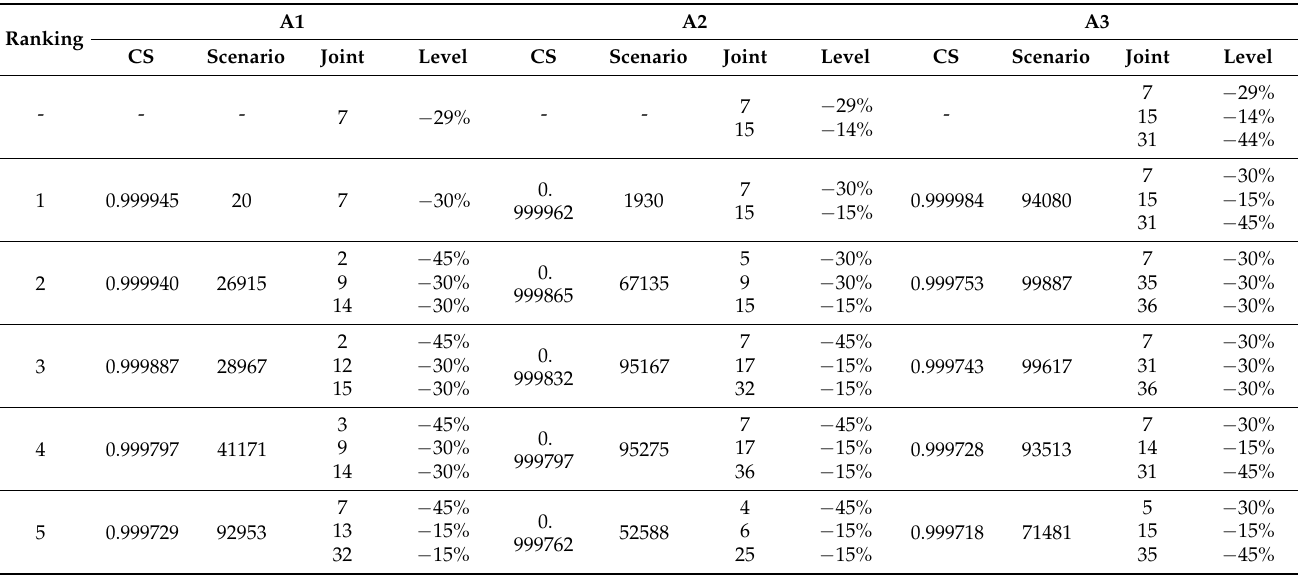
Table 7. Damage scenarios ranked in the top five and the corresponding cosine similarities (CS) of test case A.